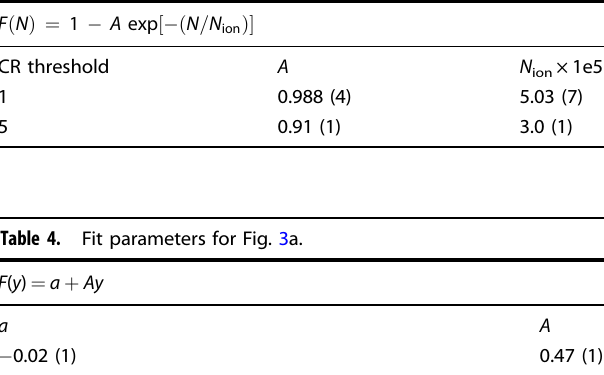
Table 3. Fit parameters for Fig. 2c, lower